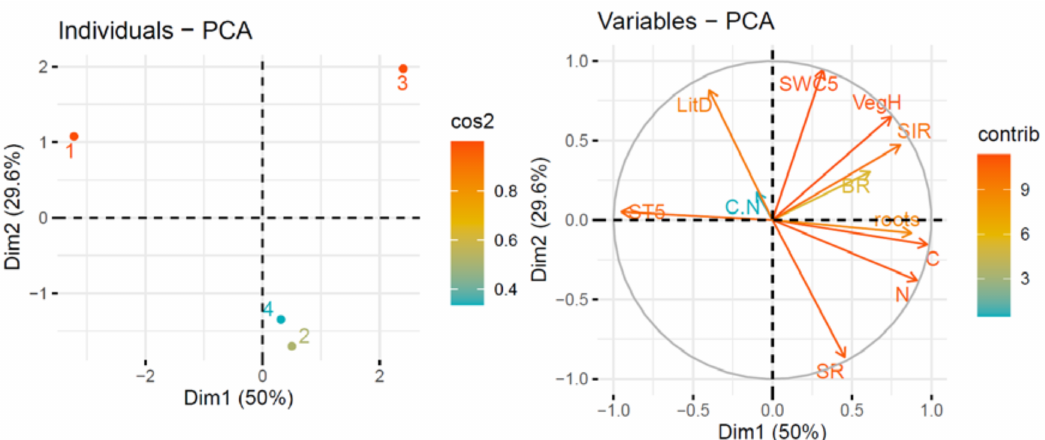
Figure 5. Principal component analysis (PCA) of the correlations between the studied parameters (variables PCA, right) and different age groups of burnt areas (individuals PCA, left). Individual PCA: ( 1 ), 0–10-year-old burnt areas; ( 2 ), 11–54-year-old burnt areas; ( 3 ), 88–141-year-old burnt areas; ( 4 ), 150–276-year-old burnt areas. Variables PCA: SR , mean soil respiration; ST5 , mean summer soil temperature; SWC5 , mean summer soil water content; C , mean soil C content; N , mean soil N content; C.N , soil C/N ratio; BR , mean soil basal respiration; SIR , mean soil substrate-induced respiration; roots , root biomass; VegH , vegetation cover height; LitD , litter thickness. cos2 , the squared cosine which represents the quality of representation for variables on the factor map. contrib , the contributions (in %) of the variables to the principal components. Table 4. The parameter contribution to the PCs in the PCA plot (Figure 5). Mean SR, mean soil